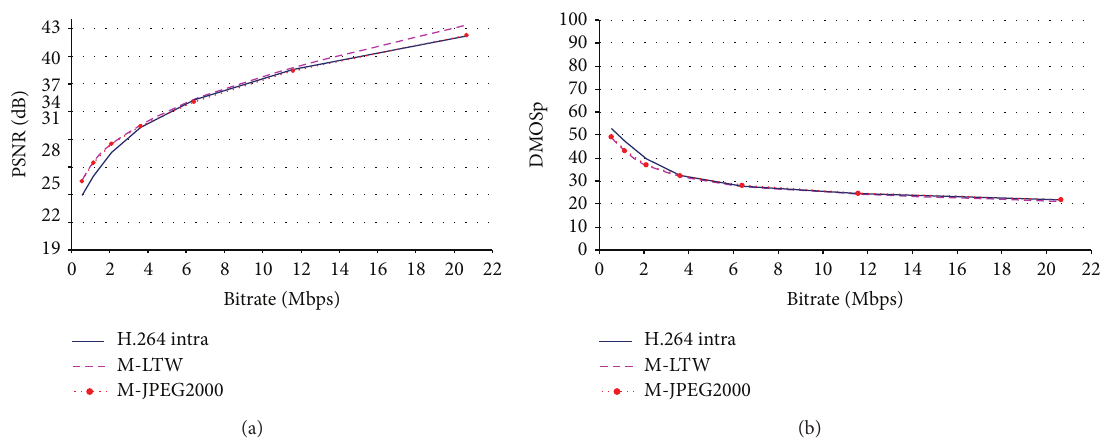
Figure 5: PSNR versus DMOSp-PSNR for the evaluated codecs (mobile sequence).